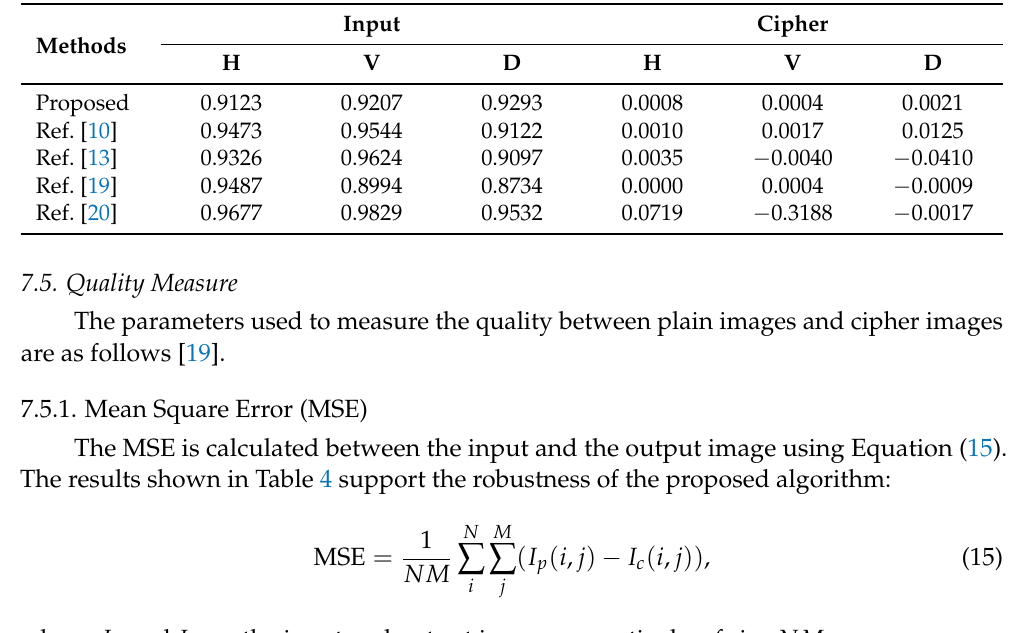
Table 3. Comparison results of the correlation coefficient with existing